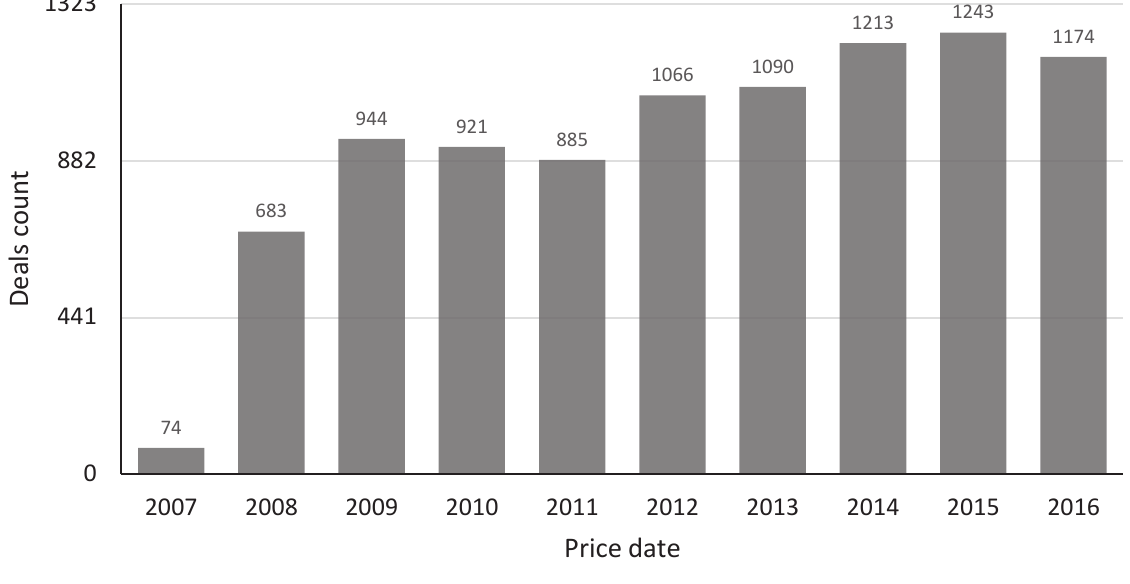
Figure 2. Number of issued bonds by year